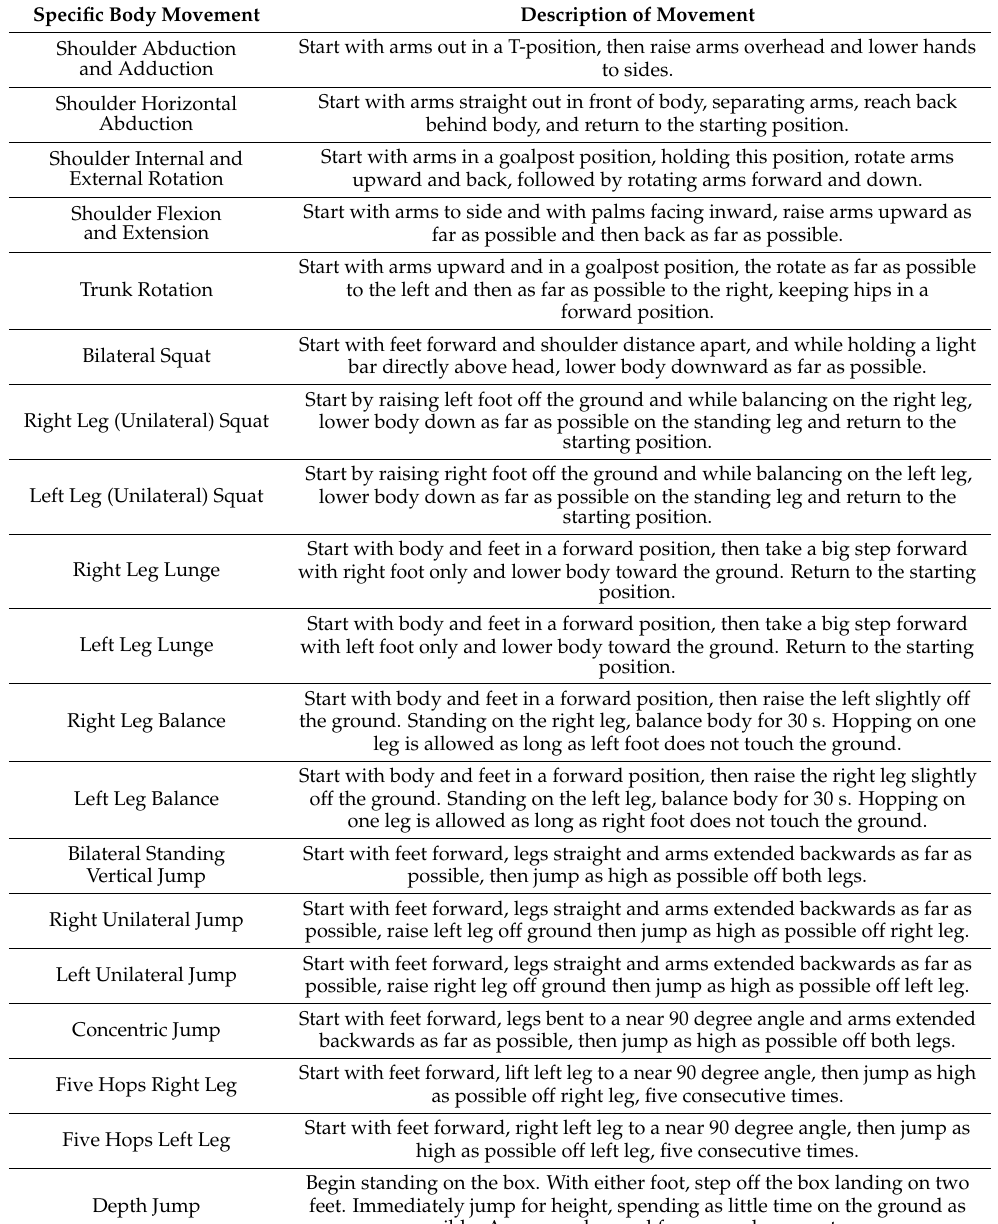
Table 1. List and description of 19 body movements incorporated into the functional movement screening